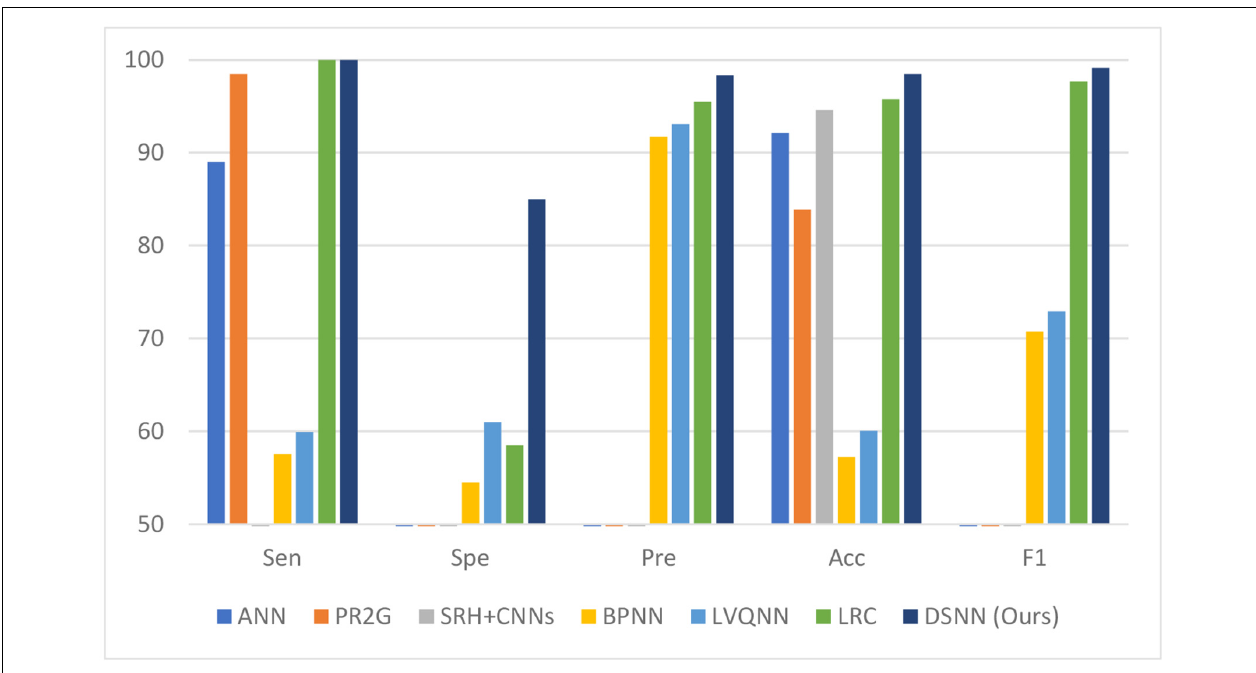
FIGURE 9 | Comparison with other state-of-the-art methods (unit: %).